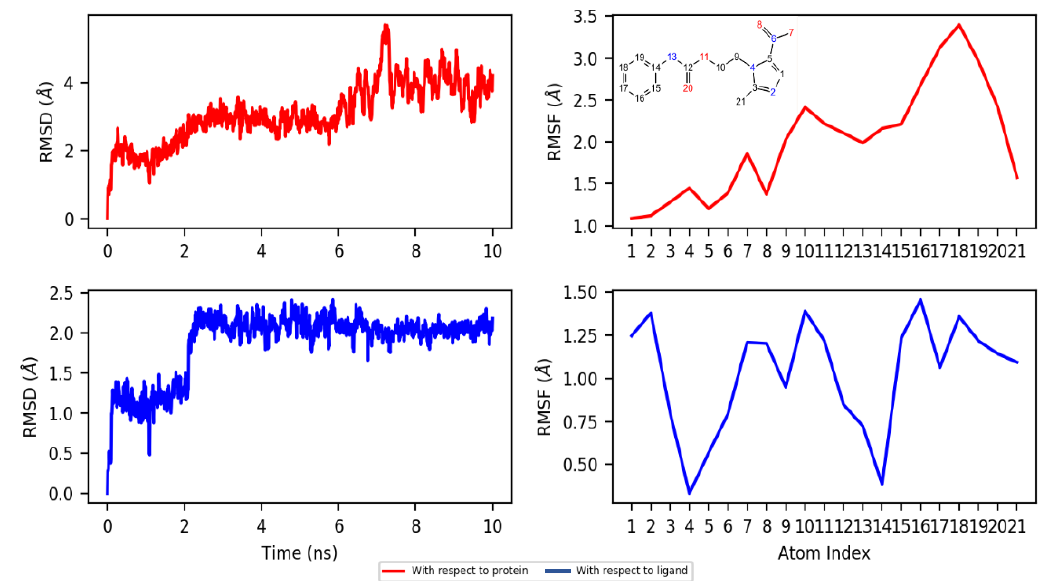
Figure 10. Dynamics of the top pose of compound 2 in the ligand recognition site of PFOR. RMSD (left) and RMSF (right) are shown with respect to protein fit (red) and the initial pose (blue).